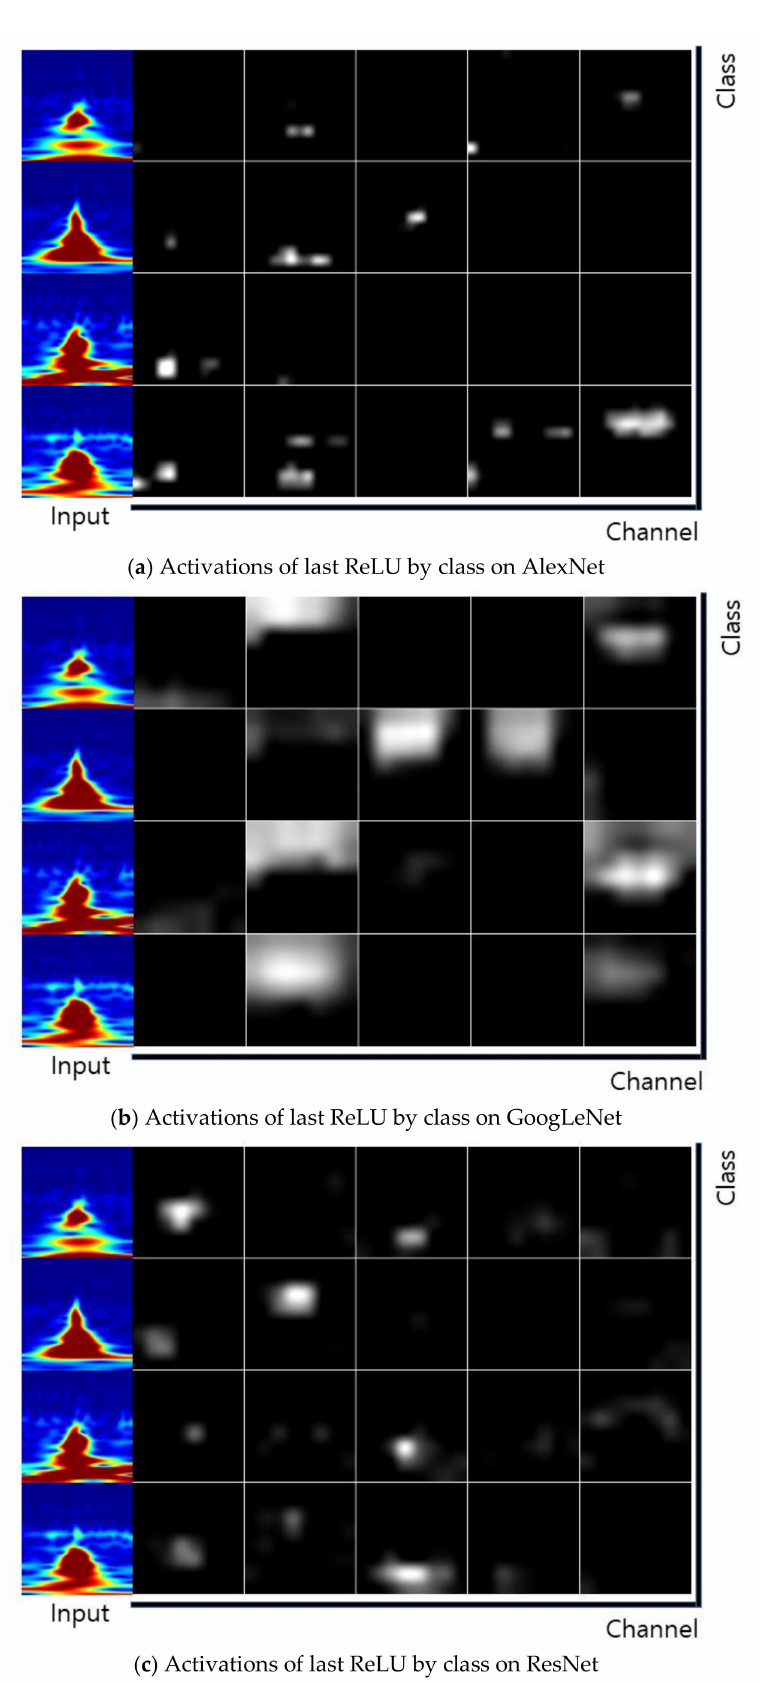
Figure 12. Comparison of the activations of the last ReLU (Rectified Linear Unit) by class in